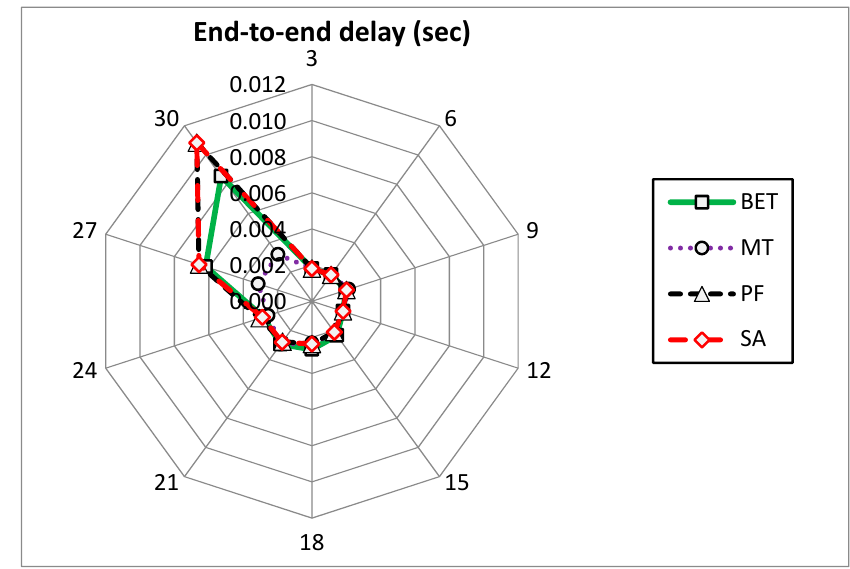
Figure 4. Average packet end-to-end delay results for far video users.